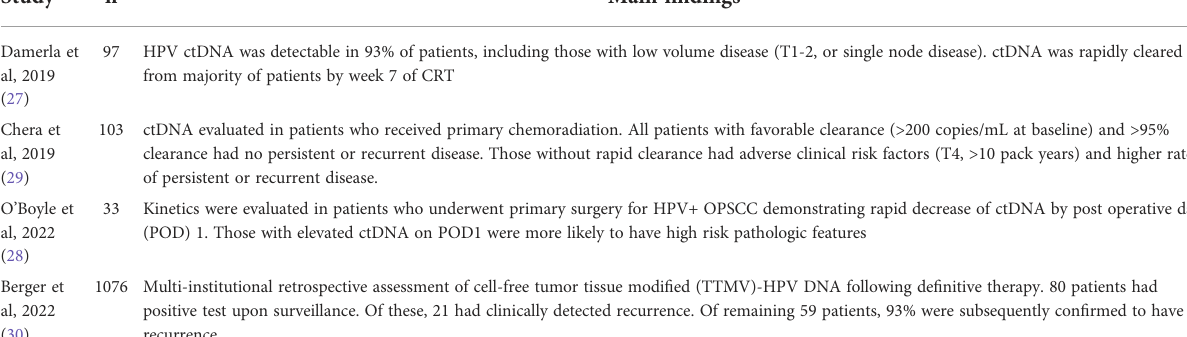
TABLE 1 HPV ctDNA clearance and recurrence detection in OPSCC.